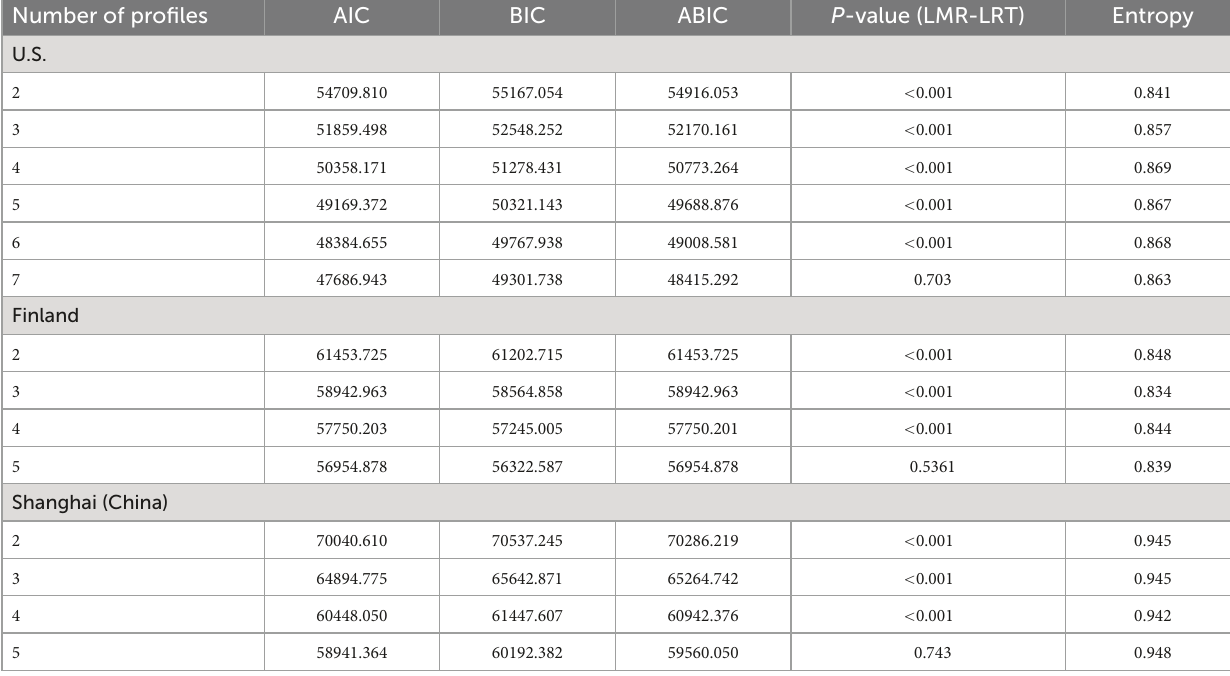
TABLE 5 Fit statistics for LCAs modeling teacher perceptions of school climate. Number of profiles AIC BIC ABIC P -value (LMR-LRT) Entropy